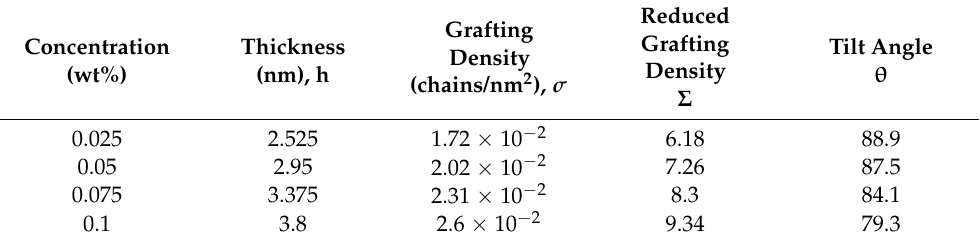
Table 1. Thicknesses and grafting densities of Poly (6-(4-methoxy-azobenzene-4’-oxy) hexyl methacry- late) (PMMAZO) with different concentrations, and induced tilt angle of nematic LC 5CB on the